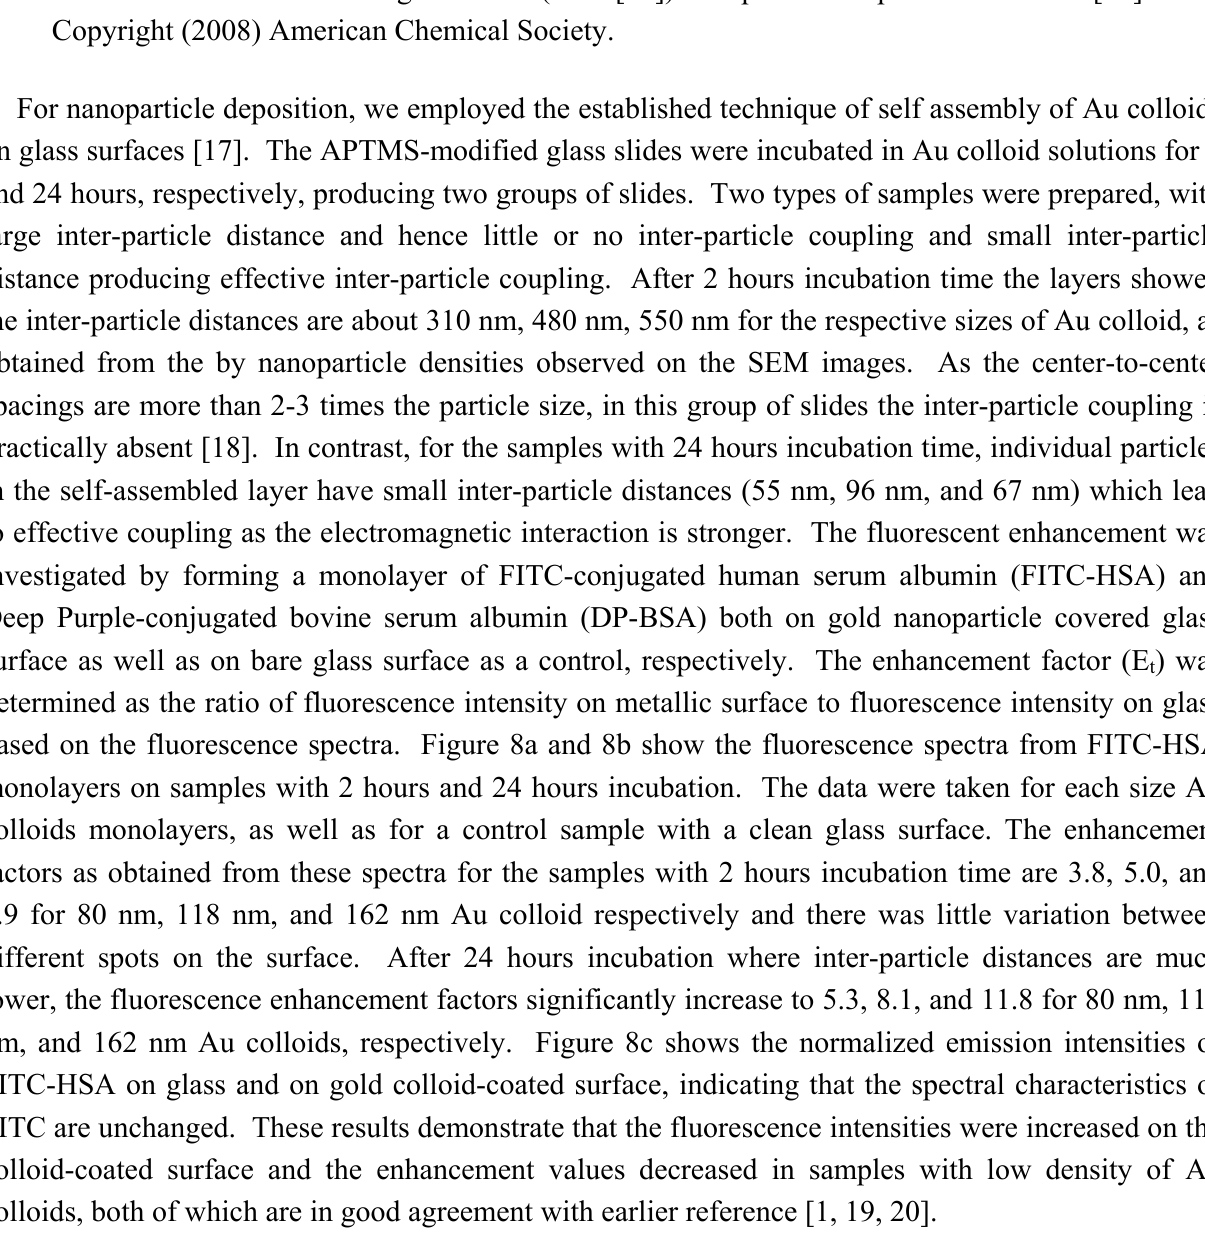
Figure 7. SEM images of (A) 80 nm Au colloid; (B) 118 nm Au colloid; (C) 162 nm Au colloid after 24 hours deposition onto the APTMS modified glass substrates. All images were taken at the same magnification (50K